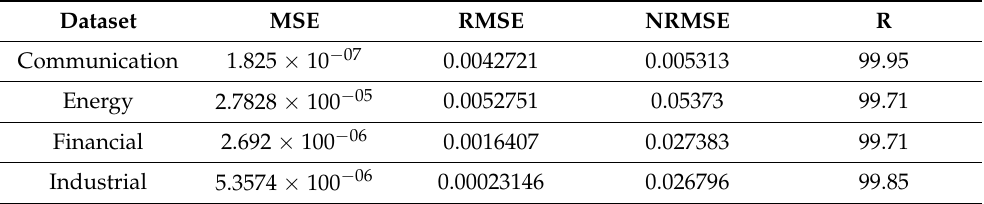
Table 4. Performance of the MLP model in the training